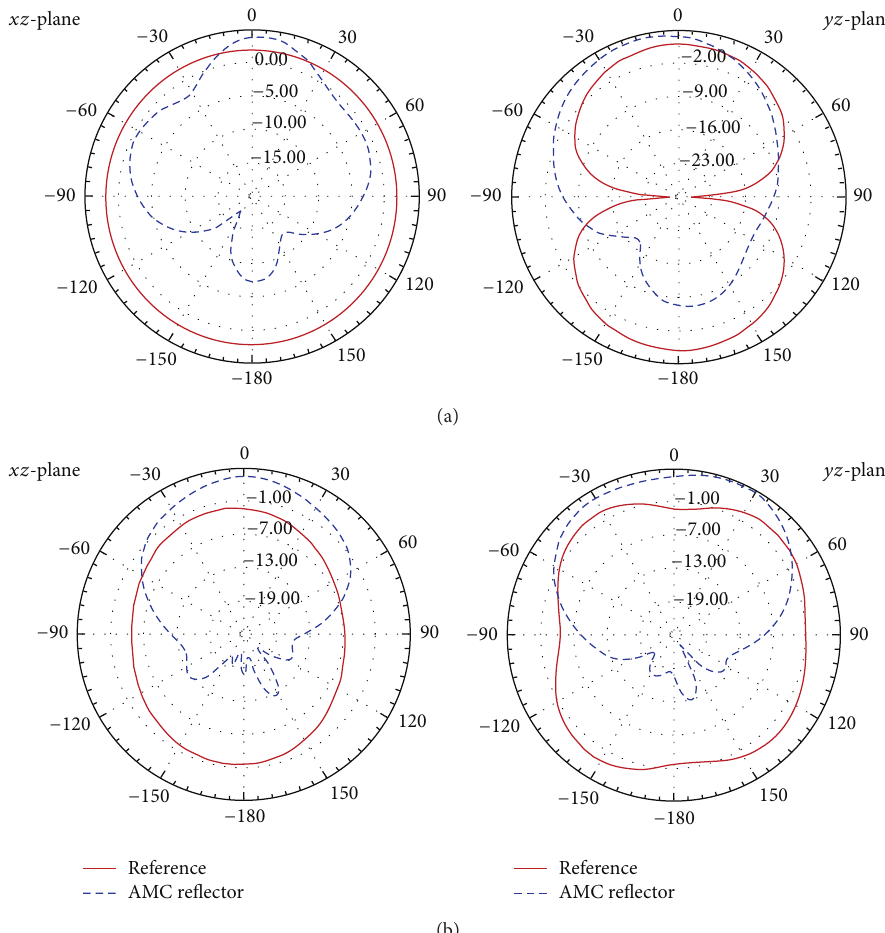
Figure 15: Radiation patterns for the reference antenna and the final design with an AMC reflector (a) 2.45 GHz, (b) 5.8